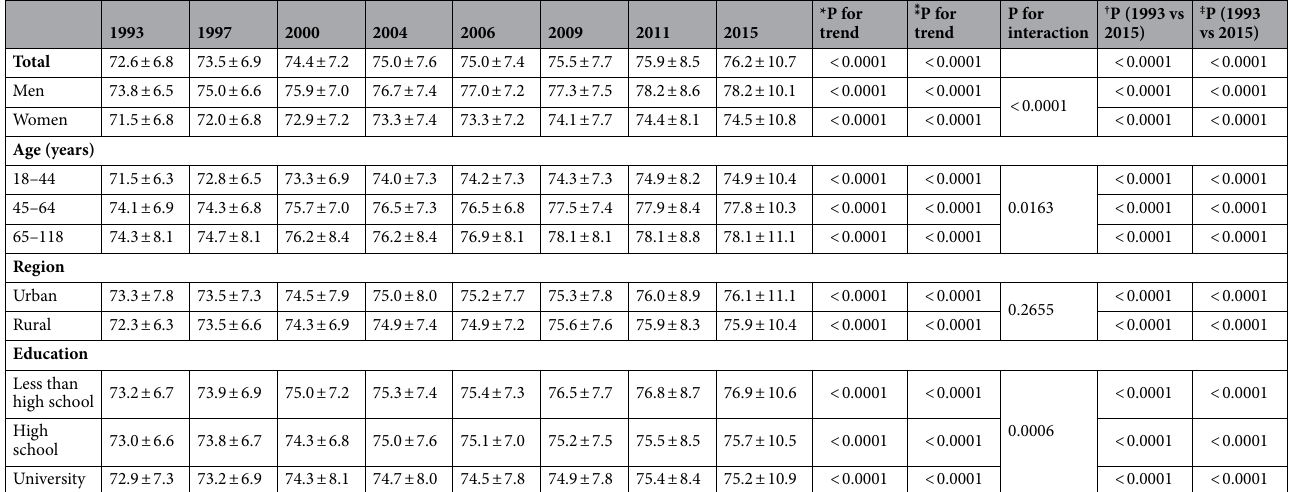
Table 2. Trends in age-standardized mean waist circumference among Chinese adults with body mass index < 23 kg/m 2 , 1993–2015. Mean WC were age-standardized to the age distribution of the China population in 2010. *P value for trend analysis. Linear regression model was used without any adjustment in the model. ⁑ P value for trend analysis in which age, sex, region, and educational attainment were adjusted in the linear models except when used as a stratified variable. † P value for comparison of 1993 and 2015. One-way ANOVA was used to compare differences. Applying the Bonferroni method for adjusting for multiple comparisons. There were 28 implied comparisons and an α = 0.0018 (α = 0.05/28) was used. ‡ P value for comparison of 1993 and 2015 after adjusting for age, sex, region, and educational attainment except when used as a stratified